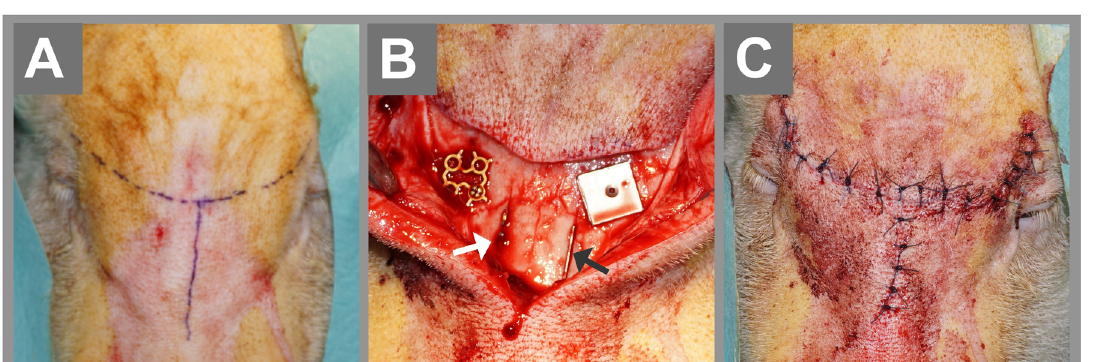
Fig. 1 Photographs of the subperiosteal implants measuring 10 × 10 mm 2 . The NiTi implant ( A ) was manufactured with a central screw hole. The control titanium implant was cut from a commercial dynamic mesh consisting of struts and screw holes. The titanium mesh was obtained from Stryker GmbH (Dynamic Mesh 54-00647, thickness 0.6 mm, Stryker GmbH, Duisburg, Germany) ( B